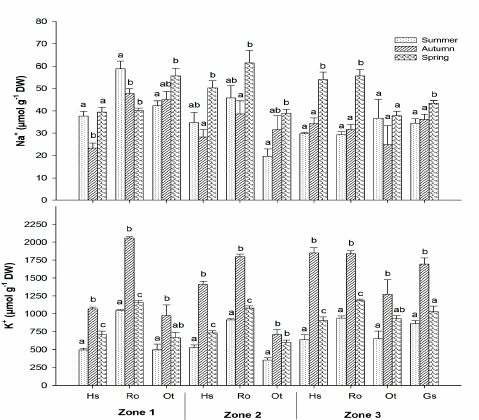
Fig. 4. Variation of monovalent cation (Na + and K + ) contents in the investigated taxa, in the three plots under study in summer 2009, autumn 2009 and spring 2010. Different letters indicate seasonal significant differences within each species and plot. Species